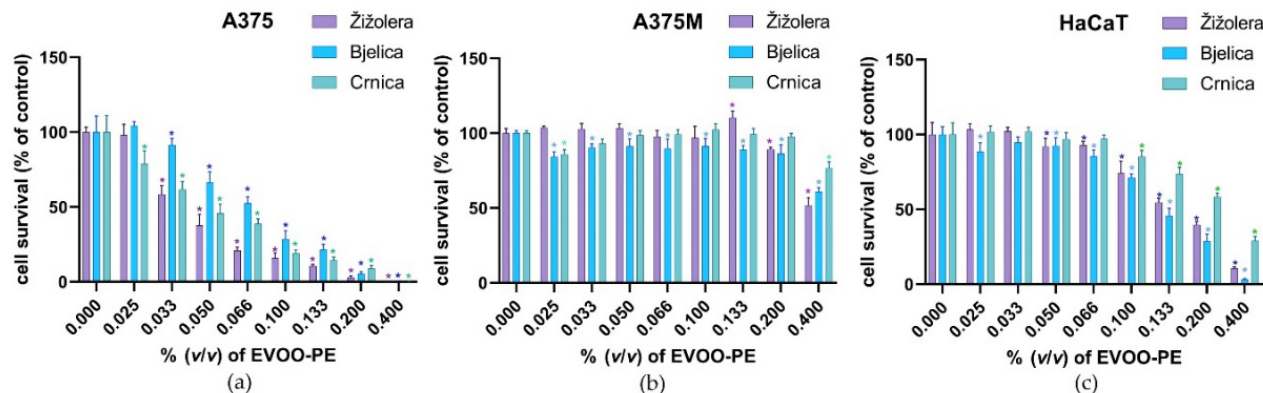
Figure 3. Effect of various concentrations of EVOO-PEs derived from different cultivars on cellular metabolic activity. Three cell lines, the ( a ) A375 melanoma cell line, ( b ) the A375M metastatic melanoma cell line, and ( c ) HaCaT immortalized keratinocytes, were exposed for 48 h to various concentrations of EVOO-PEs derived from different cultivars (Žižolera, Bjelica, and Crnica). Metabolic activity was measured using an MTS assay. The results of the six experiments are expressed as a mean percentage of cell viability compared to non-treated cells ± SD. Statistically significant differences ( p < 0.05) compared to non-treated cells are marked with an asterisk.